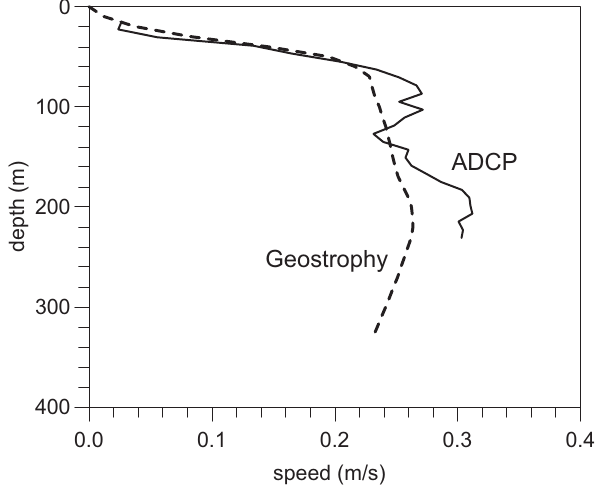
Fig. 4. Profiles of northward velocity in the eastern St. Anna Trough. Dashed line: geostrophic velocity between stations 14 and 15. Solid line: averaged profile (2 hours) from ship mounted ADCP measurements at station